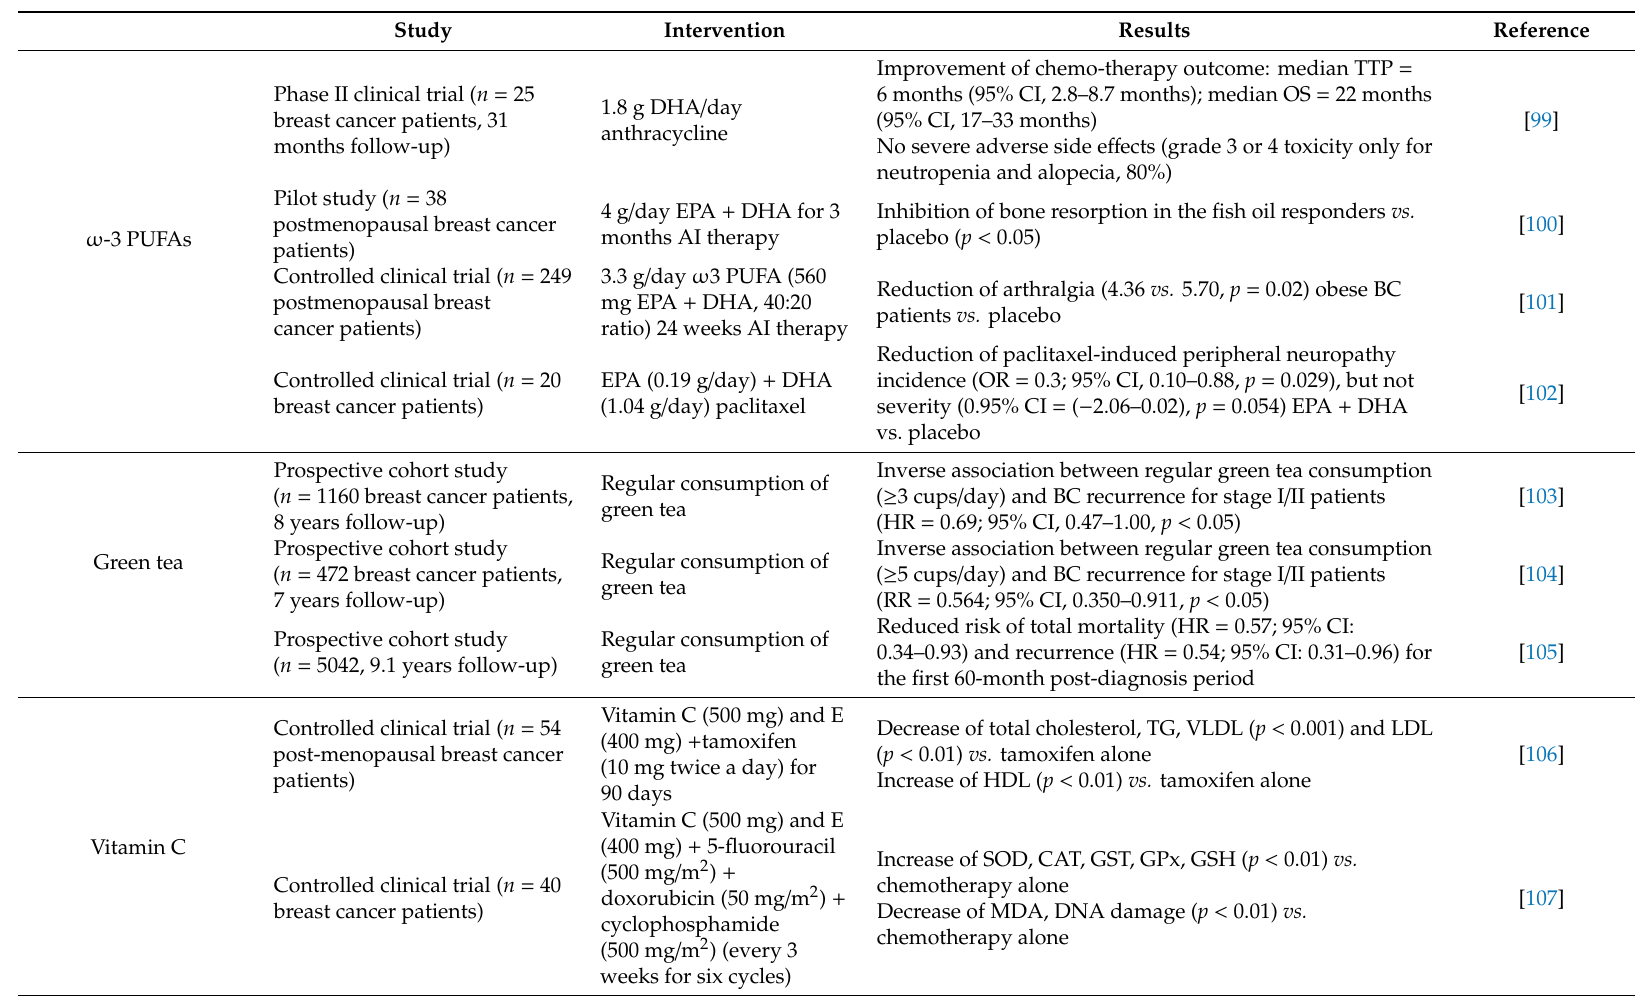
Table 2. Summary of the evidence (described in Section 5) on nutritional interventions to enhance BC